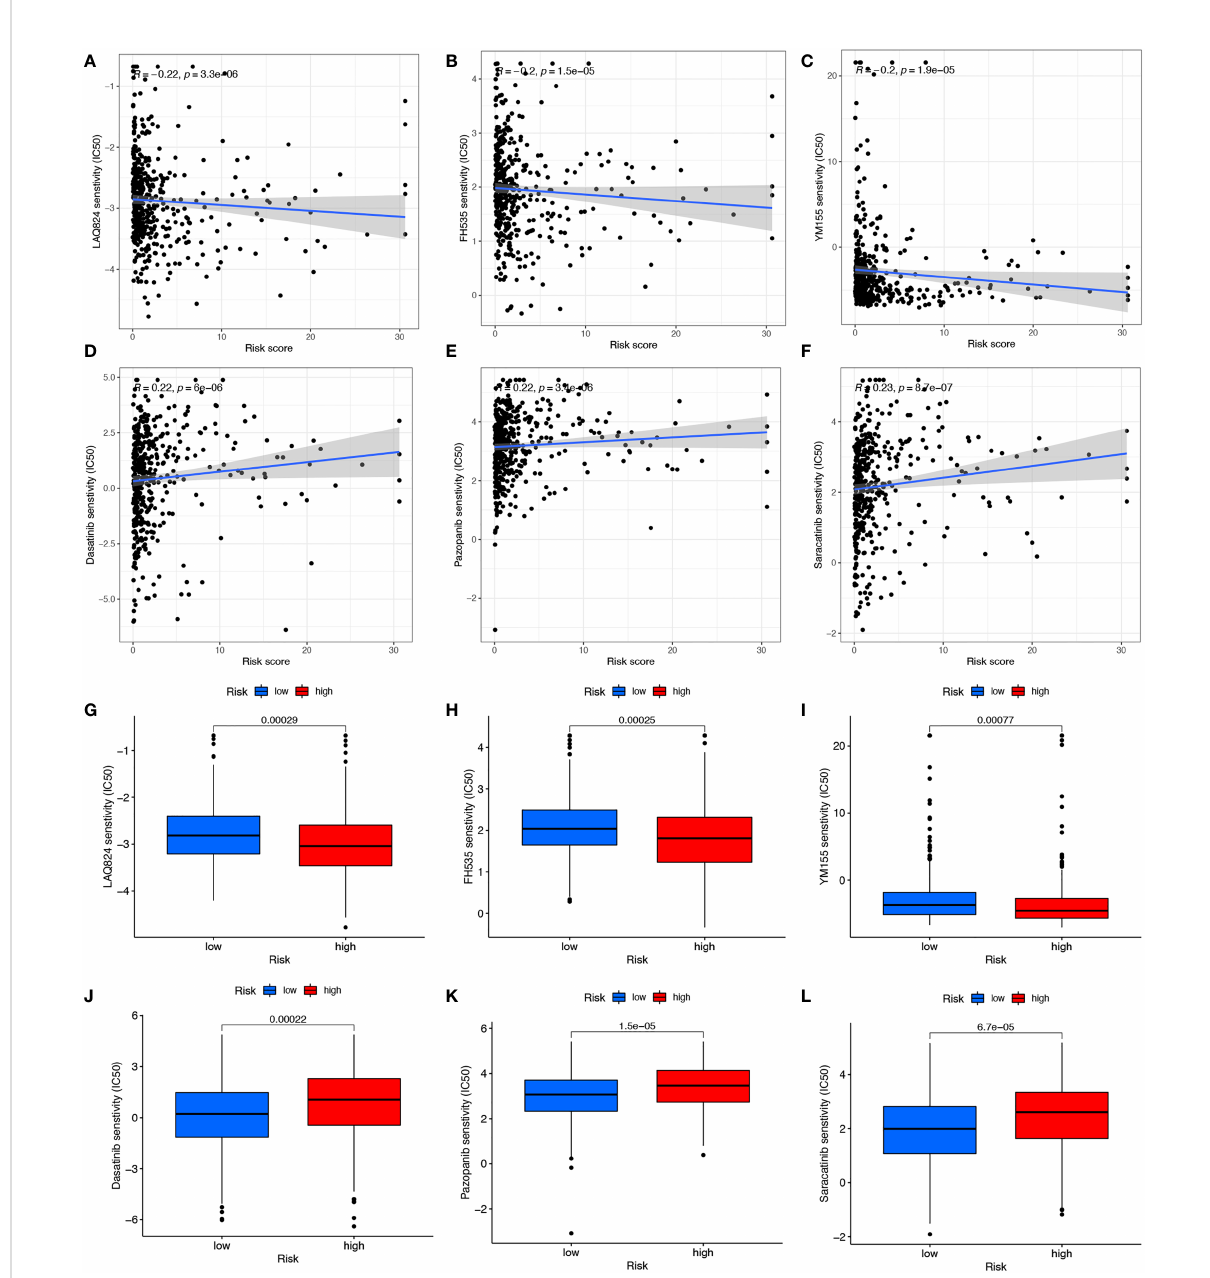
FIGURE 7 Drug correlation and sensitivity analysis of LAQ824 (A, G) , FH535 (B, H) , YM155 (C, I) , Dasatinib (D, J) , Pazopanib (E, K) and Saracatinib (F, L)